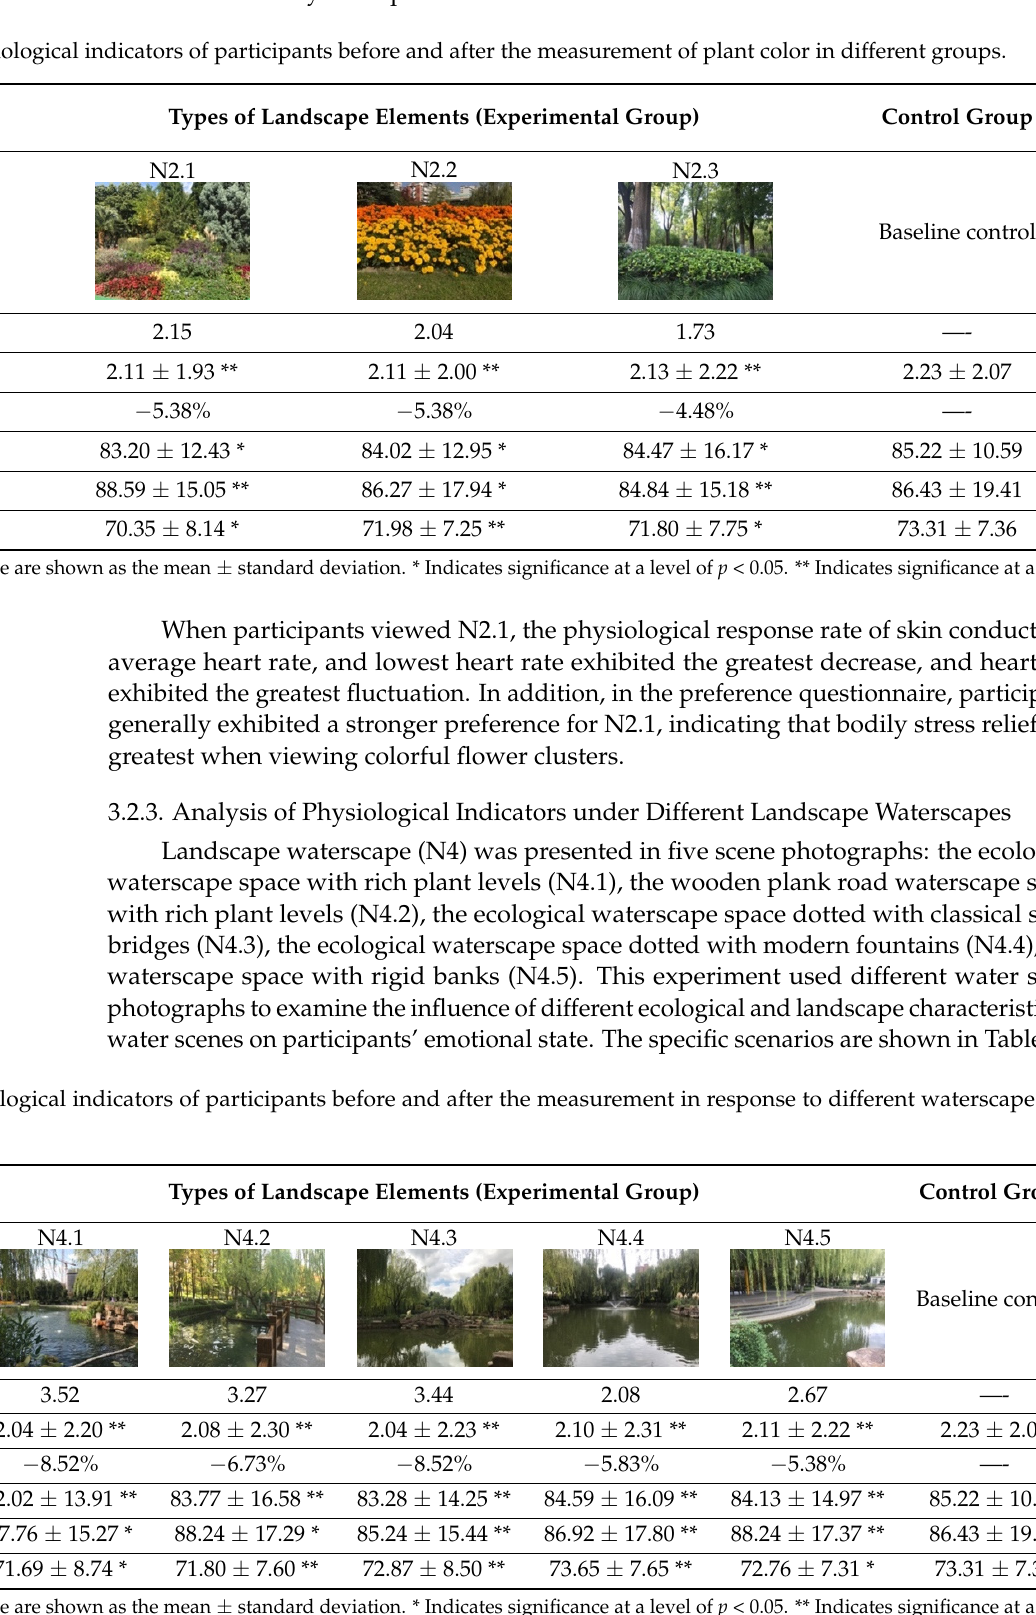
The data in the table are shown as the mean ± standard deviation. * Indicates significance at a level of p < 0.05. ** Indicates significance at a level of p < 0.01.